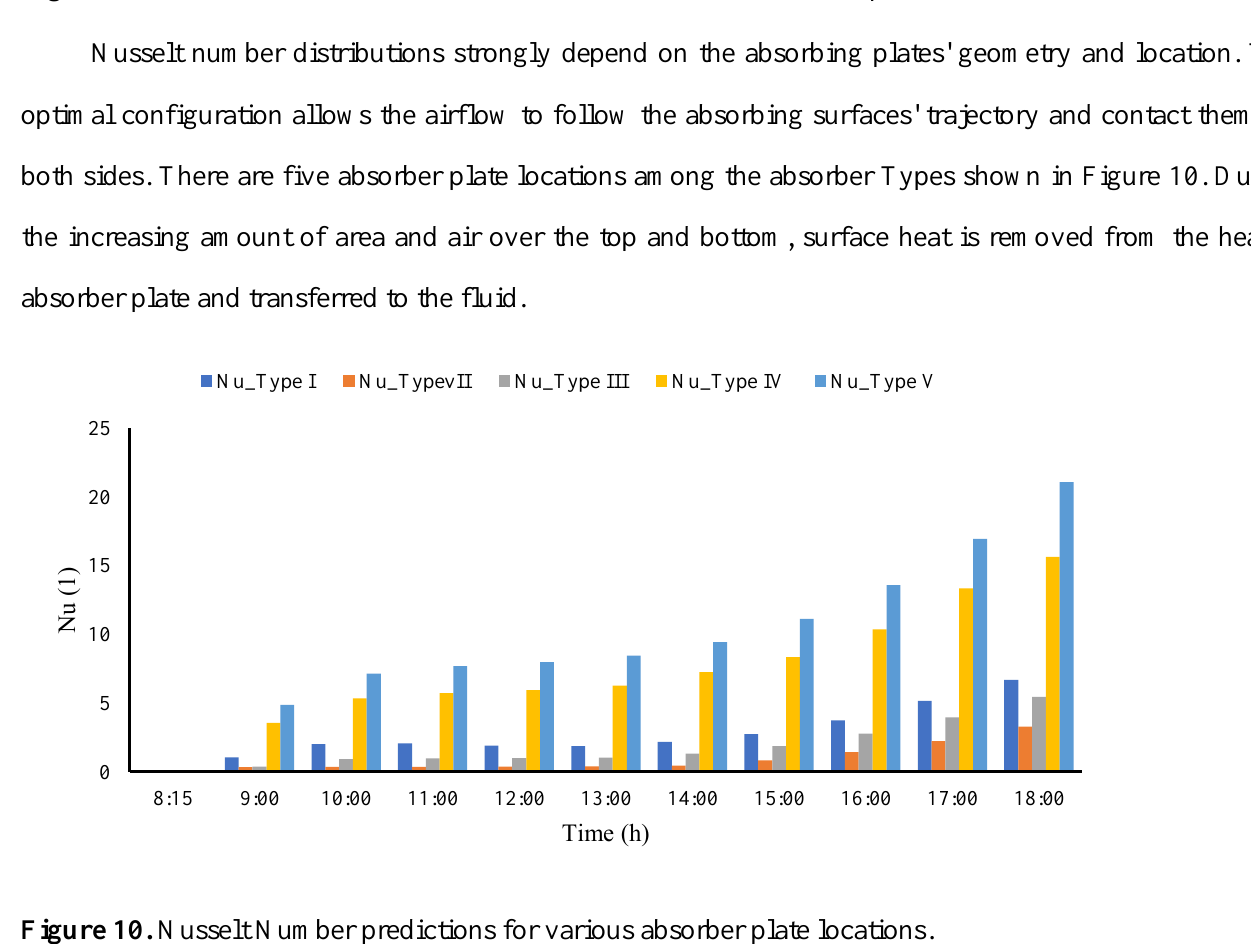
Figure 10. Nusselt Number predictions for various absorber plate